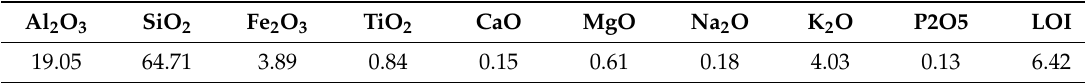
Table 3. Chemical composition in the basis clay material.